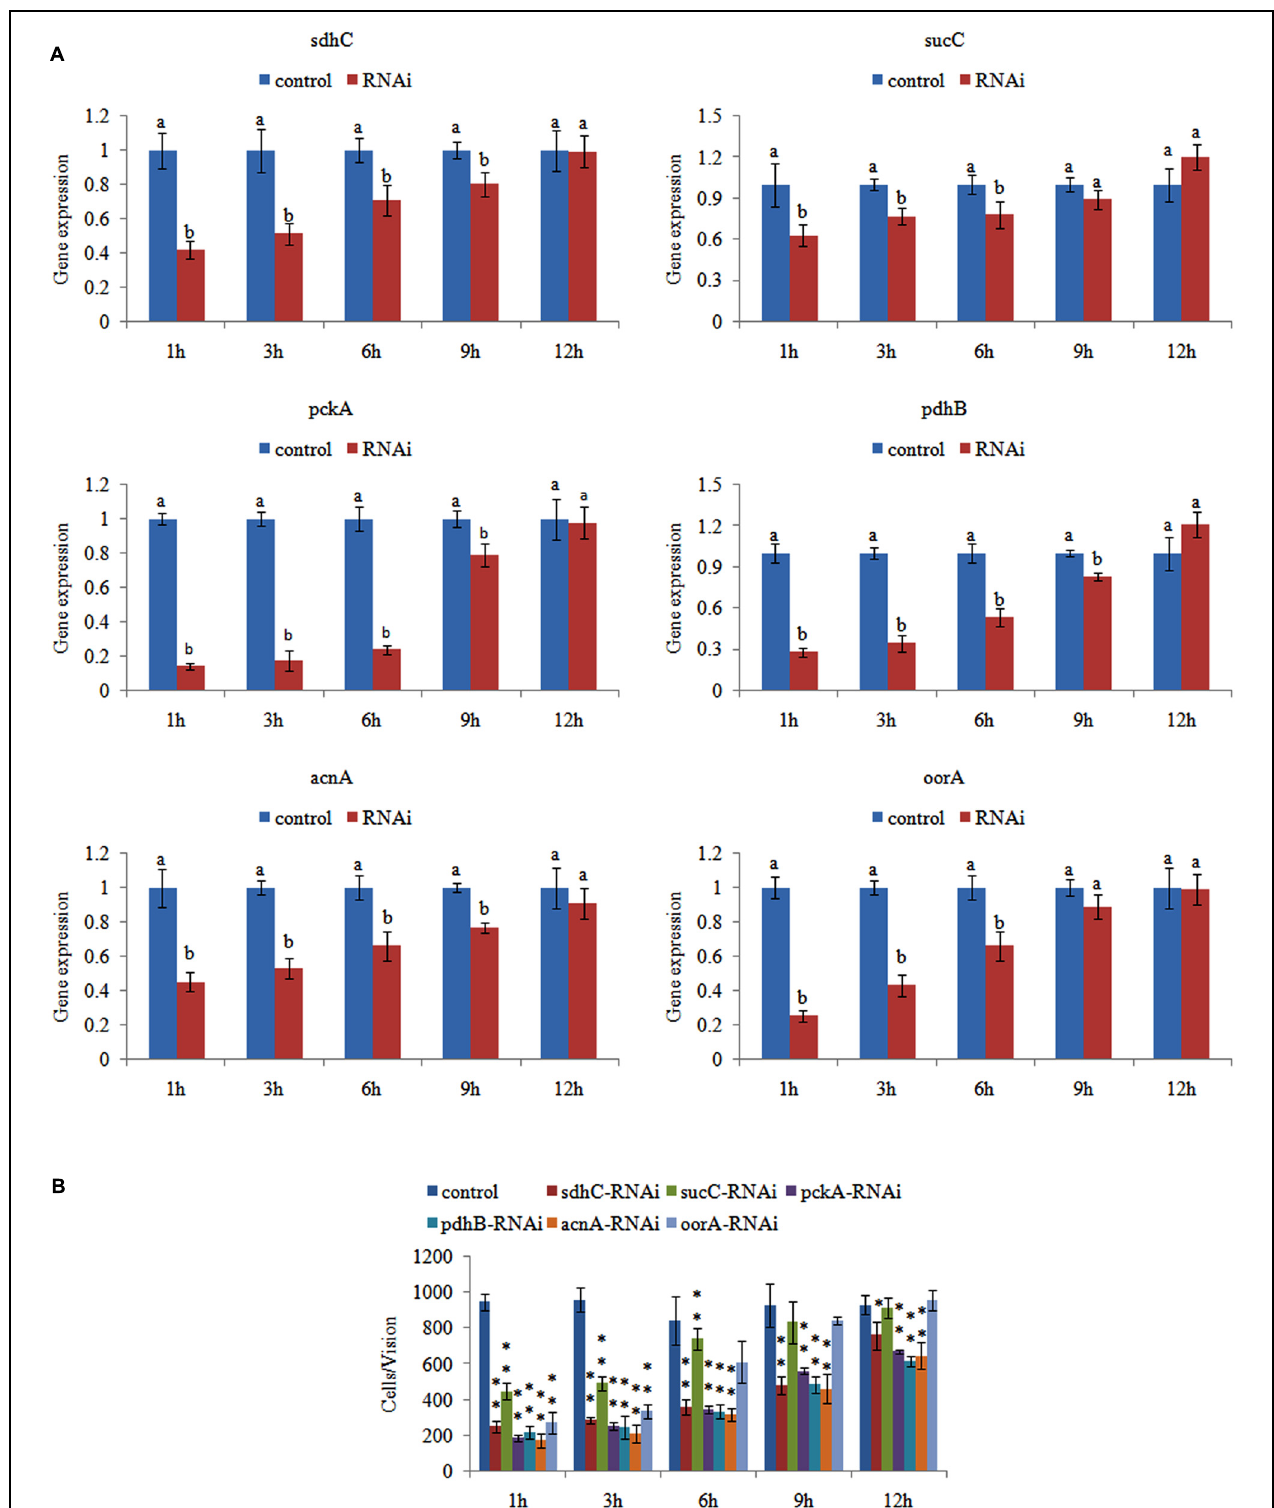
FIGURE 2 | Transient RNAi reduced the adhesion of Vibrio alginolyticus . (A) QPCR analysis of the expression of sdhC , sucC , pckA , pdhB , acnA , and oorA after transient gene silencing at 1, 3, 6, 9, and 12 h in comparison to the control. The data are presented as the means ± SD, n = 6. The means of the treatments not sharing a common letter are significantly different at P < 0.05. (B) The adhesion capacity to mucus of transient silenced V. alginolyticus at 1, 3, 6, 9, and 12 h. The data are presented as the means ± SD, n = 3. ∗∗ P < 0.01 versus the control group. ∗ P < 0.05 versus the control group.